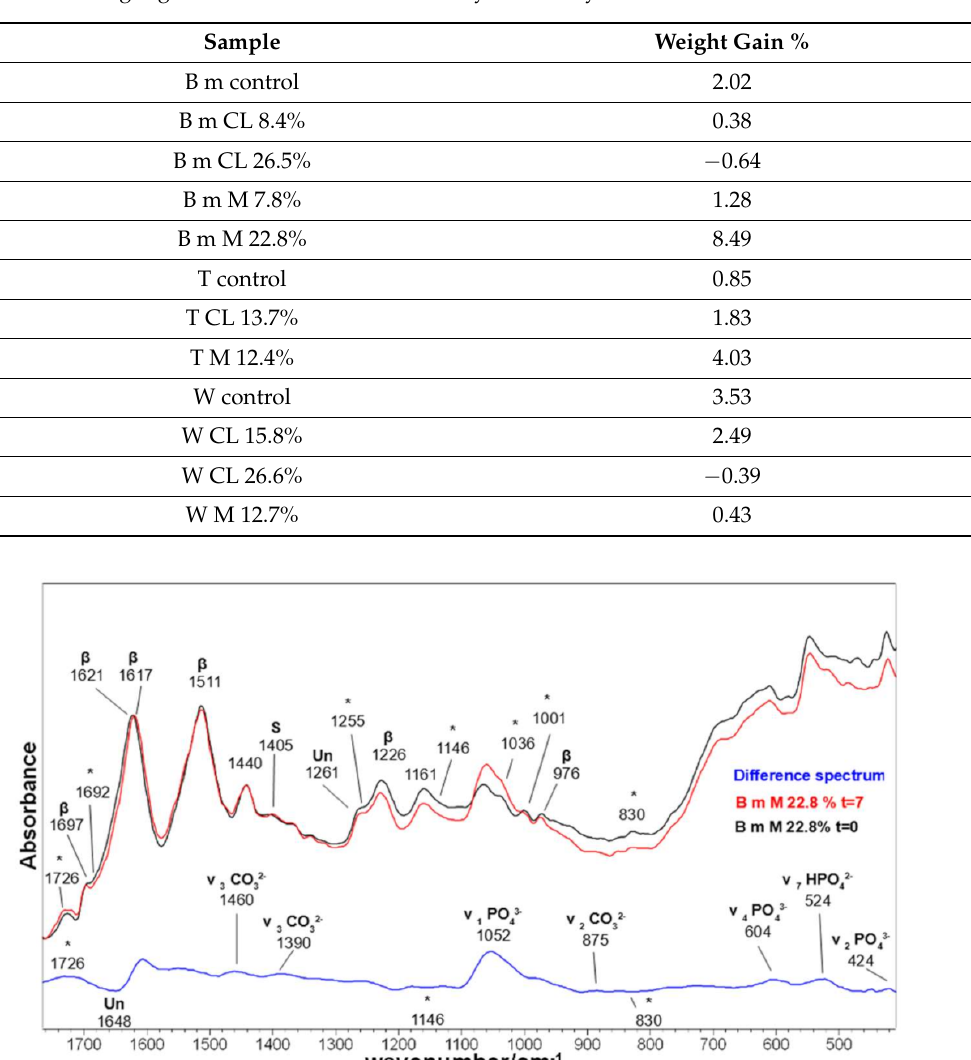
Table 2. Weight gain % of the fabrics under study after 7 days in the SBF solution.